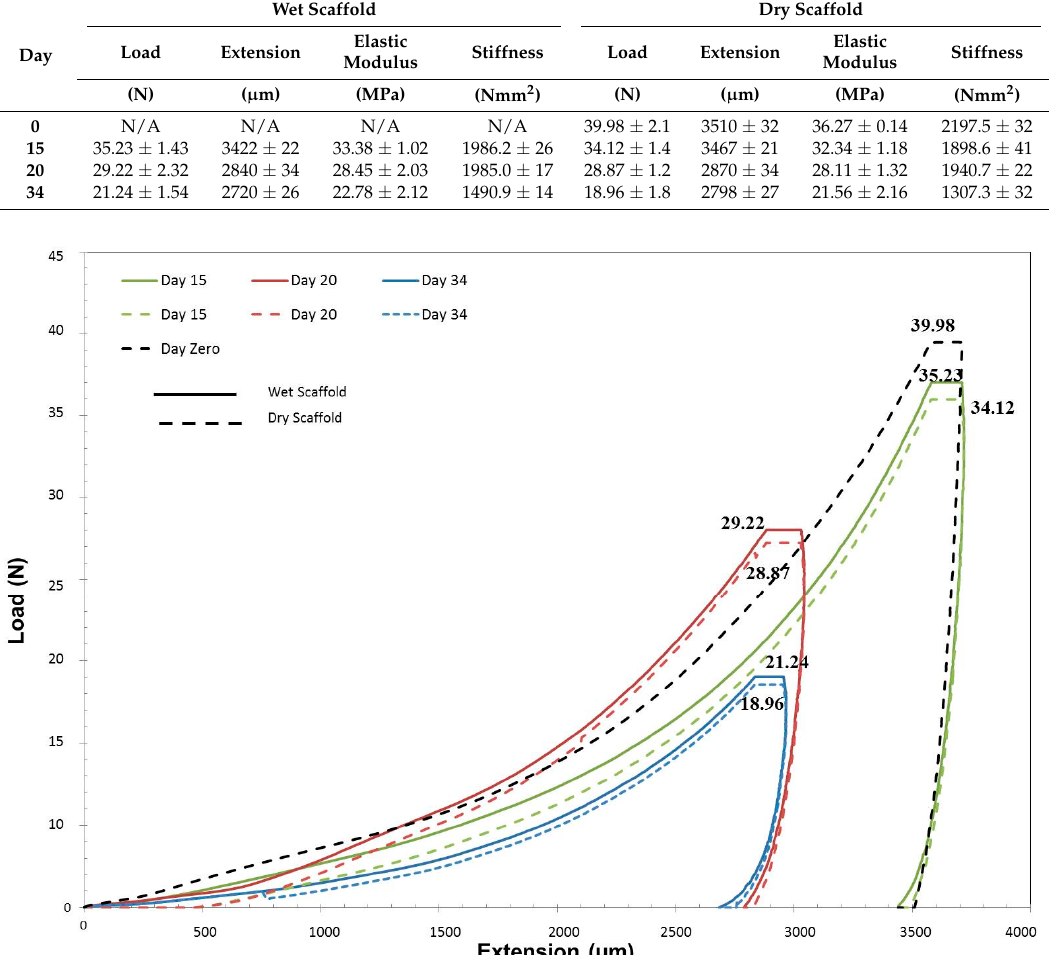
Figure 10. Load vs. extension curve for 3D scaffold after 15, 20 and 34 days of cell seeding.